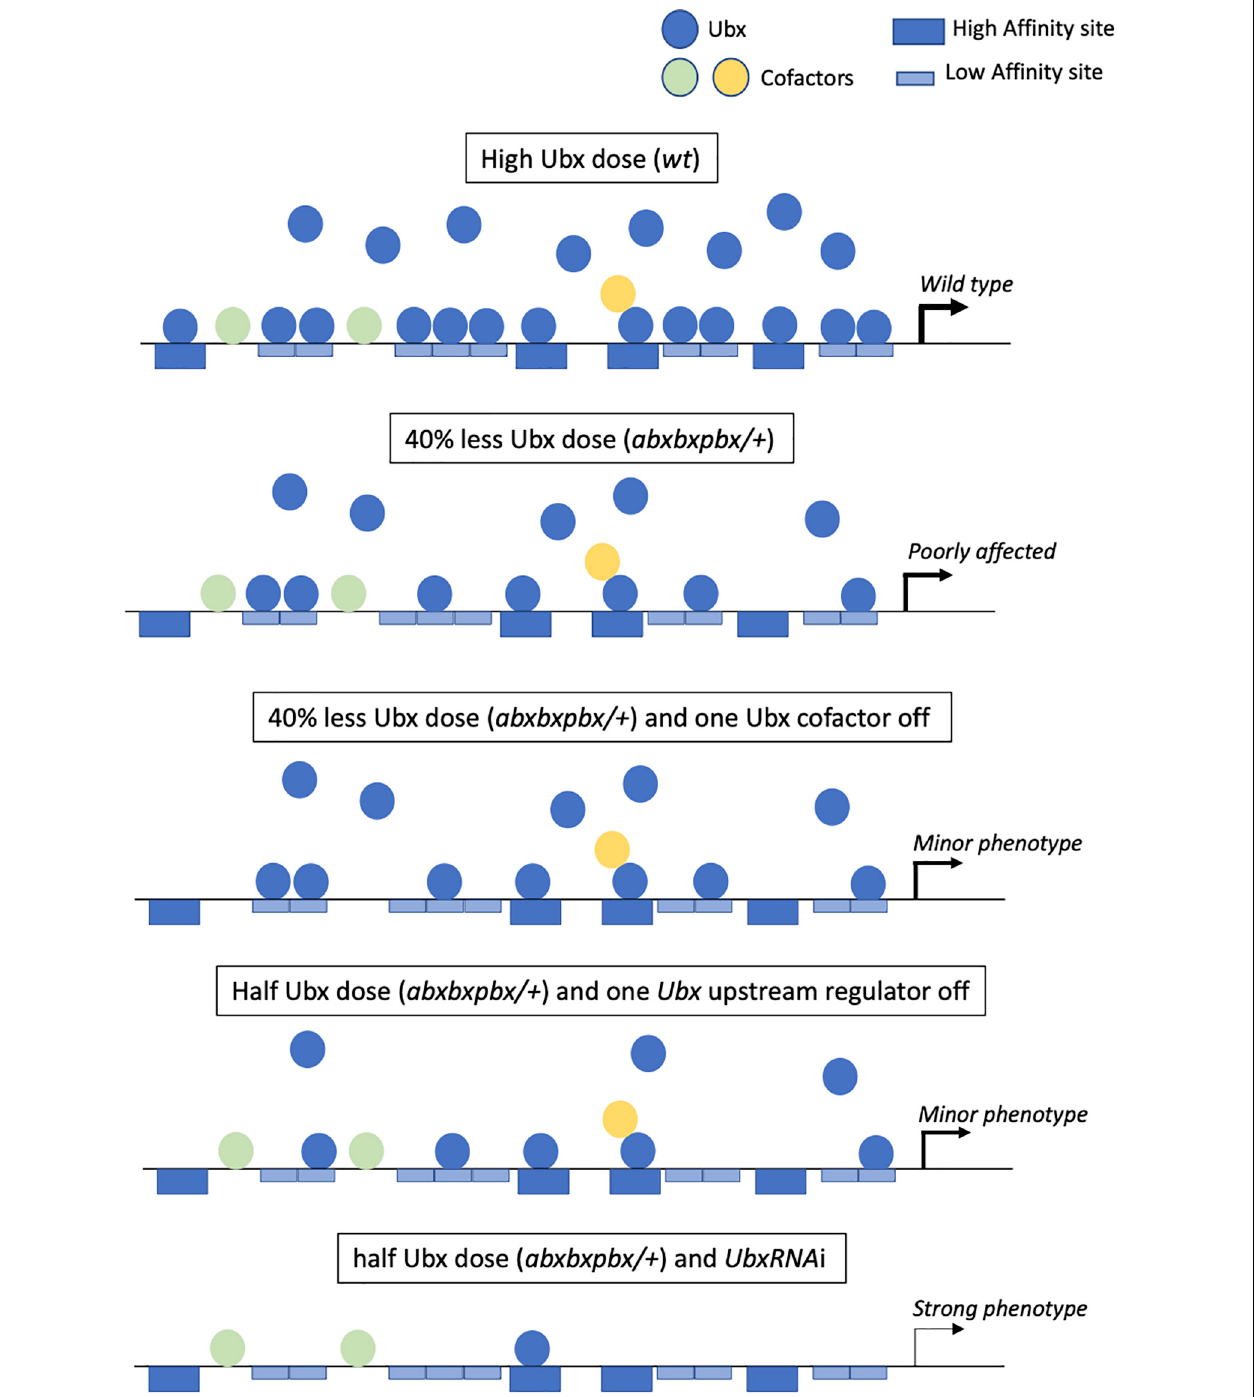
FIGURE 4 | The “self-sufficient” molecular model of Ubx in the haltere disc. Ubx (blue balls) recognizes several redundant high affinity (dark-blue large boxes) and low-affinity (light-blue large boxes) monomeric binding sites in target enhancers at normal (high) doses in the haltere disc. Few cofactors (colored balls) are acting as collaborators (without making dimeric DNA-bound Ubx/cofactor complexes) that modulate the transcriptional output of Ubx. In the context of the heterologous abxbxpbx mutant background, there is still enough Ubx molecules to bind on the majority of the redundant monomeric sites, allowing ensuring the haltere developmental program without major morphological variations. The loss of one cofactor in the wild type (not shown in the figure) or mutant context could potentially affect the regulation of some target genes, eventually leading to a subtle phenotype. The haltere morphology could also be moderately affected when targeting an upstream regulator of Ubx . Finally, only a strong decrease of Ubx expression level will affect the haltere developmental program, due to the inactivity of most monomeric binding sites in target enhancers.